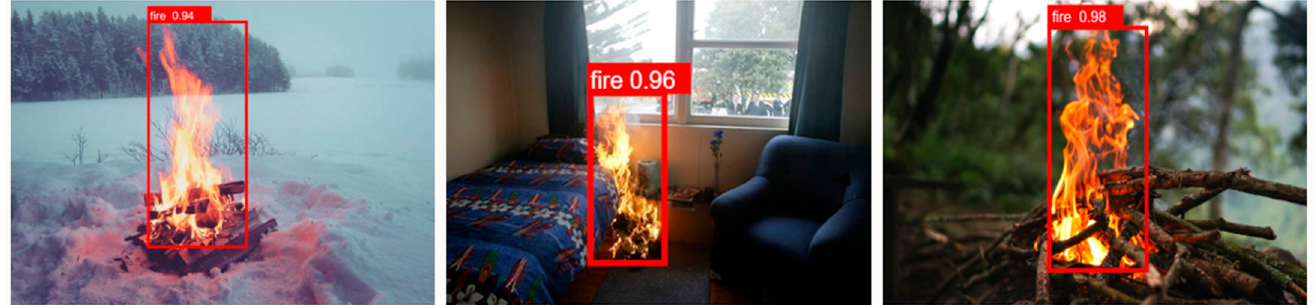
Figure 8. Results of fire detection system for day images.